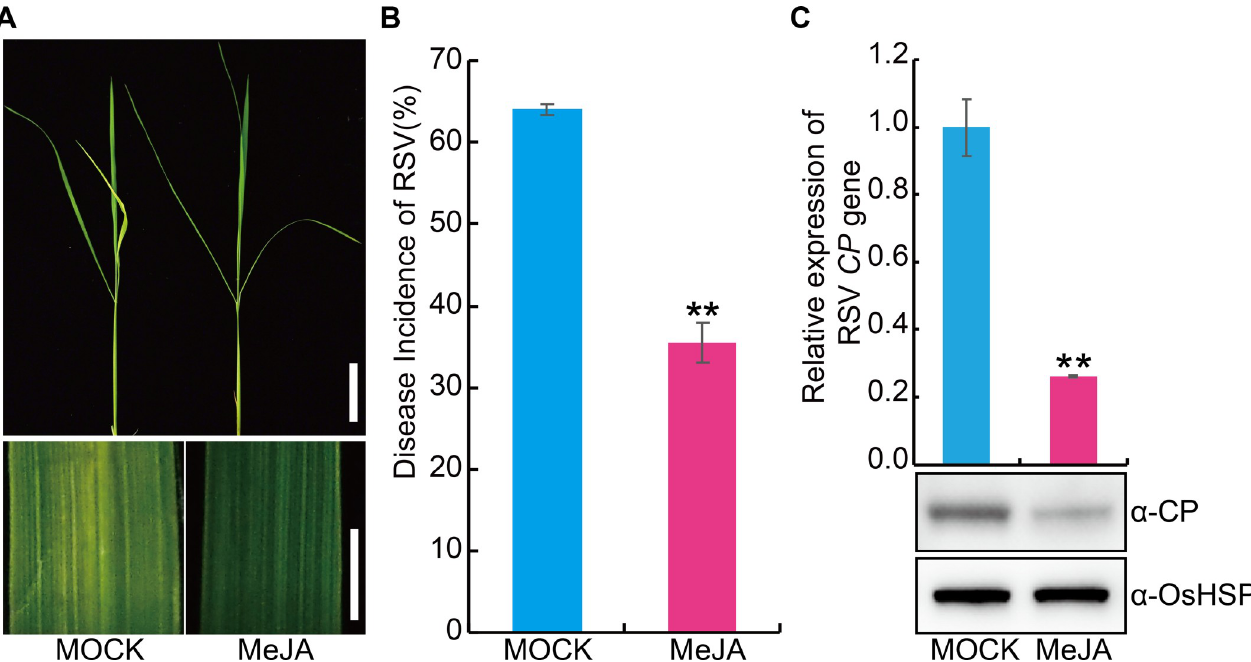
Fig 4. Exogenous application of JA significantly enhances the RSV resistance in rice. (A) Representative image of rice seedlings infested with RSV-carrying SBPH after pretreatment with MOCK (0.1% Triton X-100) or 100 μ M MeJA. Bar = 5 cm (top). Bar = 3 mm (bottom). (B) RSV incidence of rice seedlings infested with RSV-carrying SBPH after pretreatment with MOCK or 100 μ M MeJA. (C) Detection of RSV CP RNA expression levels (upper panel) by quantitative RT–PCR assay and western blot analysis of the RSV coat protein (lower panel) in the RSV-infected rice seedlings after pretreatment with 100 μ M MeJA or MOCK, respectively. OsHSP was used as loading control. Data are shown as mean ± SEM (n = 3). �� P < 0.01 by Student’s t -test in B and C.